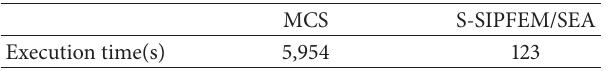
Table 9: Execution times of S-SIPFEM/SEA and the Monte Carlo simulation of the hybrid FE/SEA